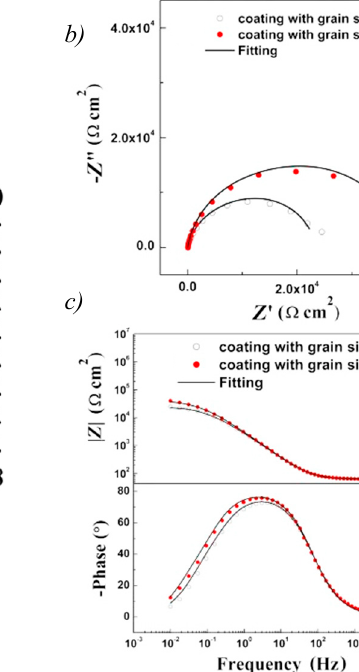
Figure 7. Effect of nanocoating and microcoating structure size. Nanograin size had the lowest i corr in 10 wt.% NaOH [53].